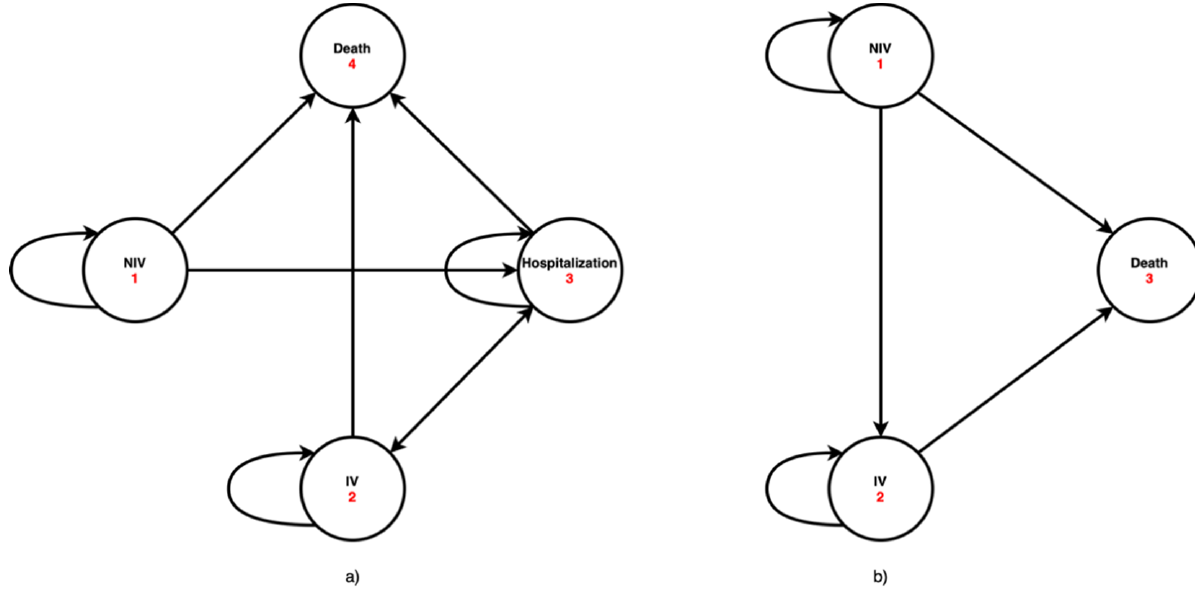
Figure 1. State diagram of the Markov model ( a ) home mechanical ventilation, ( b ) mechanical ventilation.